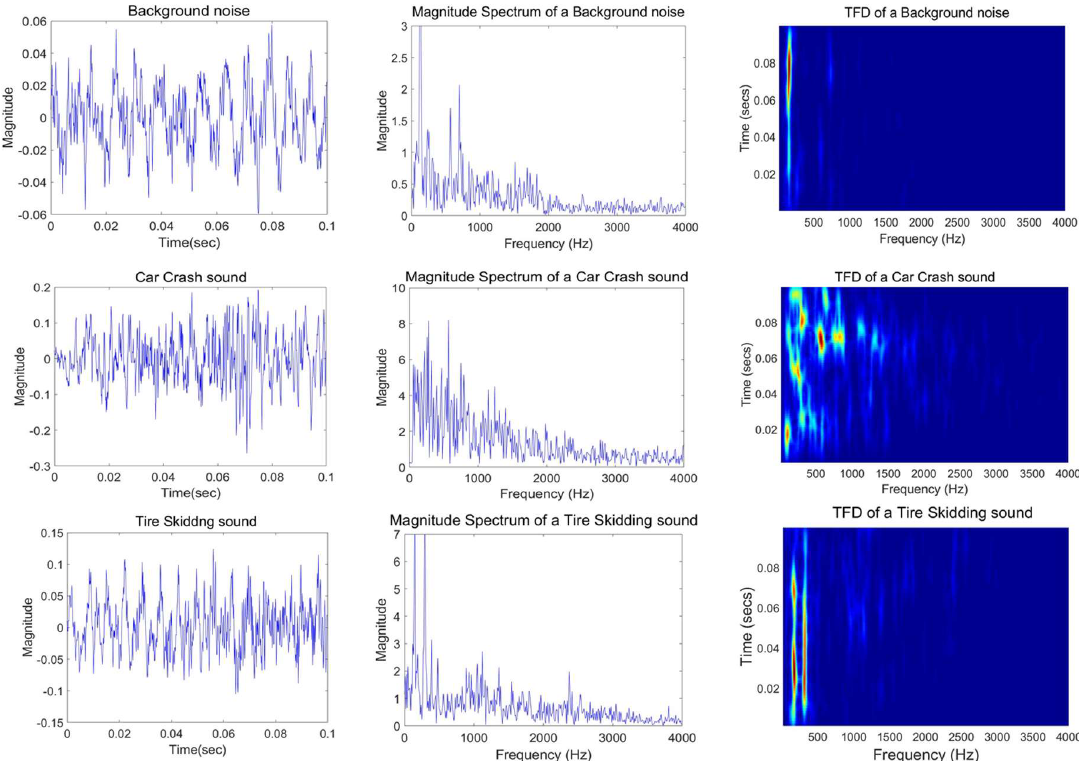
Figure 3. Time, frequency, and TF representations of a Background noise (BN) segment ( 1st row ), a Car Crash (CC) sound ( 2nd row ), and a Tire Skidding (TS) sound ( 3rd row ). The TF representations were generated using the extended modified-B distribution (EMBD) with as σ = 0.9 and β = 0.01, with a lag window length of 355.